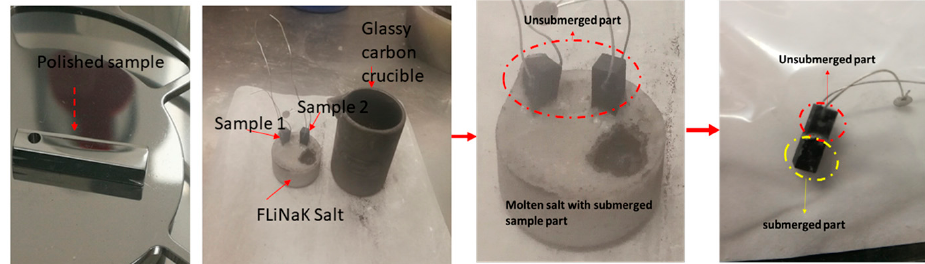
experiment, the samples were separated from the solid salt, as shown in Figure 2.